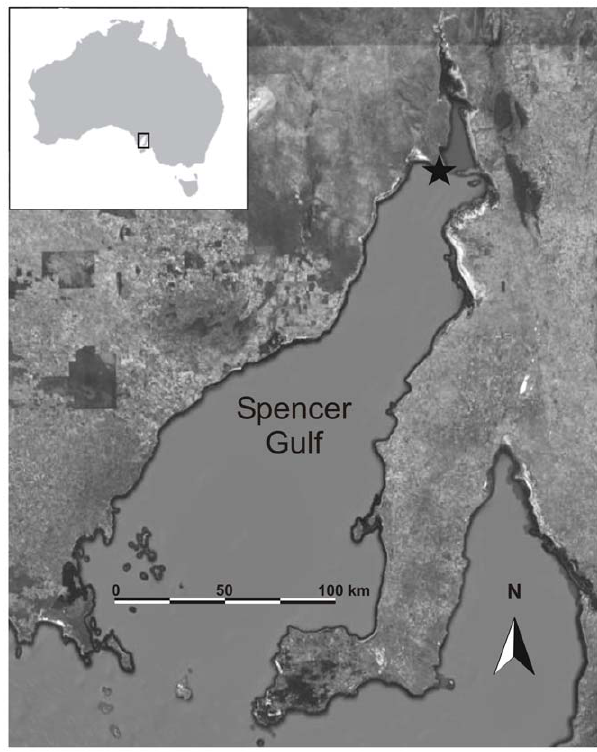
Figure 1. Location of Sepiaapama breeding aggregation (black star) in northern Spencer Gulf, South Australia. Image source: Google Earth mapping service.